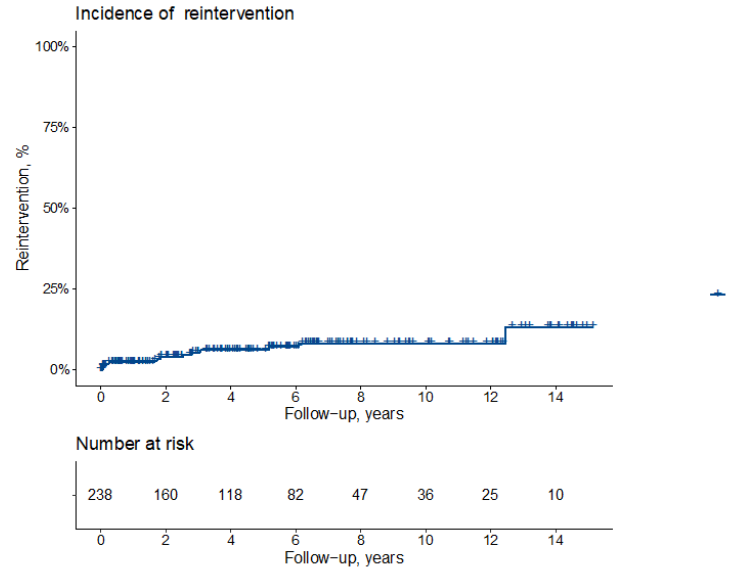
Figure 2. Cumulative incidence of reintervention (all-cause death as competing risk).